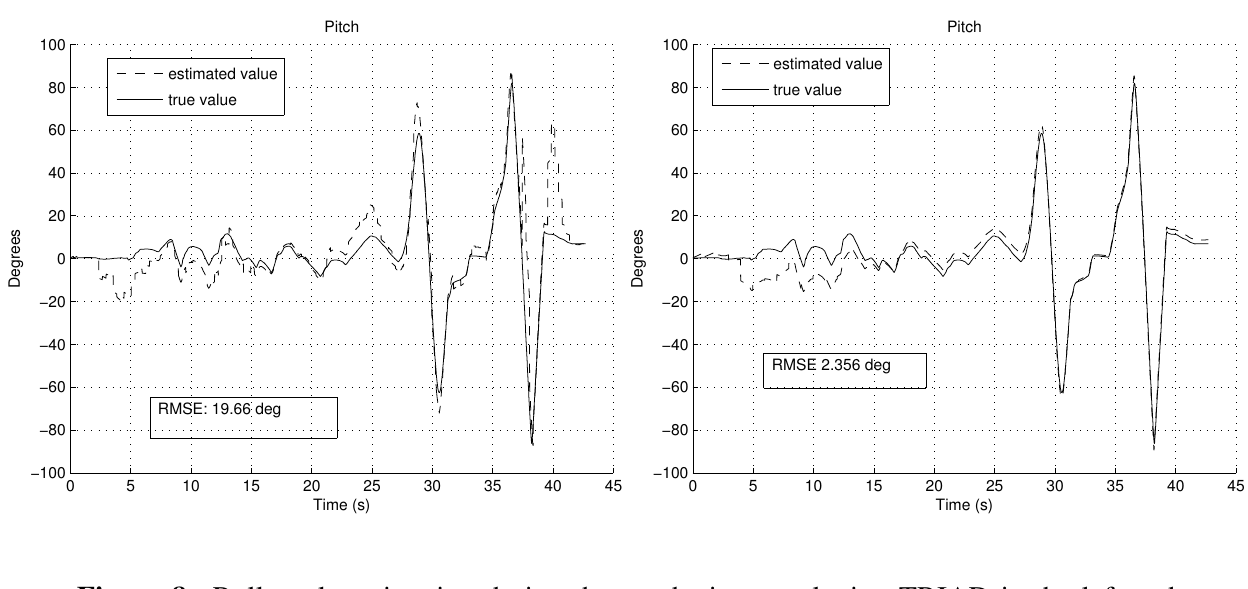
Figure 8. Roll angle estimation during the aerobatics, employing TRIAD in the left and FOAM in the right during the aerobatics simulation shown in Figure